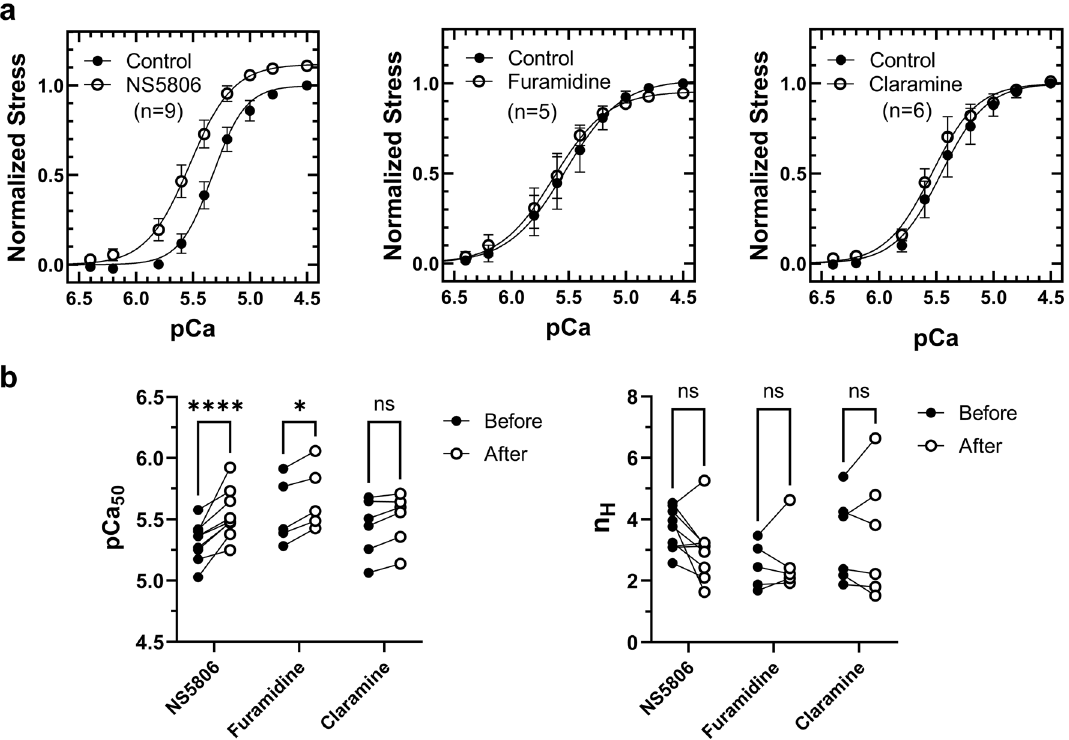
Figure 6. Functional effects of hit compounds in demembranated human myocardium. ( a ) Force-pCa relations of demembranated human myocardium in the absence and in the presence of 100 μmol/L NS5806 (left), Furamidine (middle) and Claramine (right). ( b ) Effects of hit compounds on calcium sensitivity (pCa 50 ) and cooperativity (n H ) of force development of demembranated human myocardium. Means ± SEM, n = 5–9. Statistical significance of differences between before and after drug treatment were analyzed by a two-way ANOVA followed by Sidak’s multiple comparison test: * p < 0.05, **** p < 0.0001, ns—not